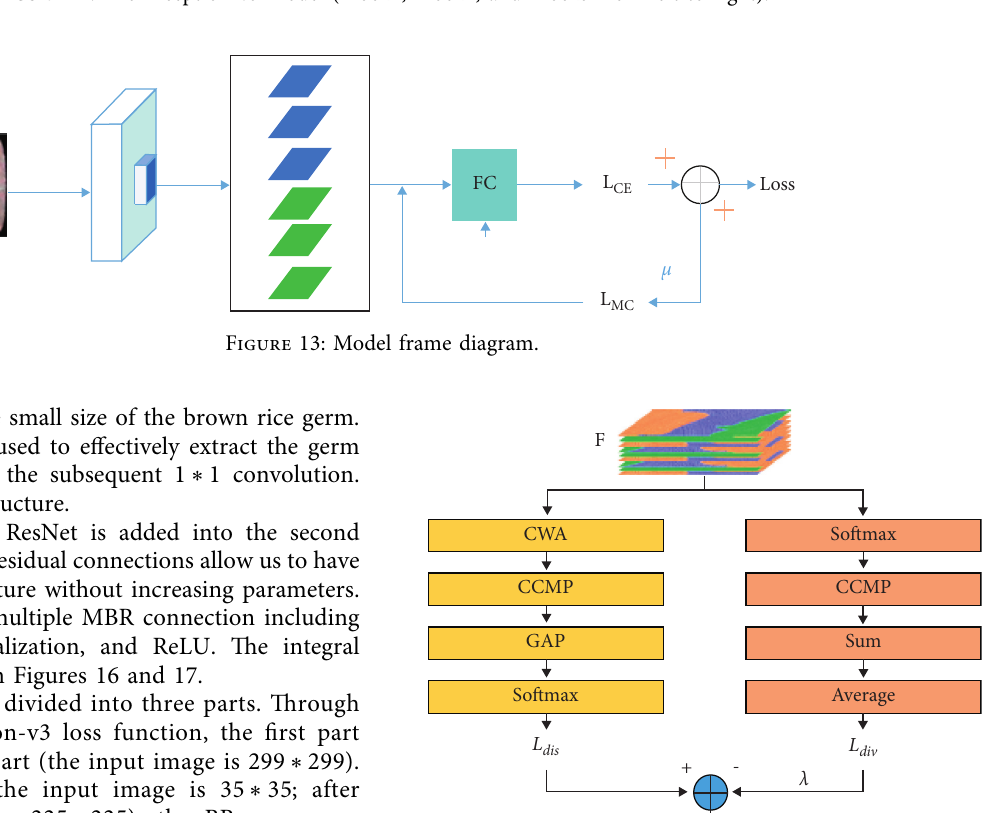
Figure 12: The Inception-v3 model (Block1, Block2, and Block3 from left to right).